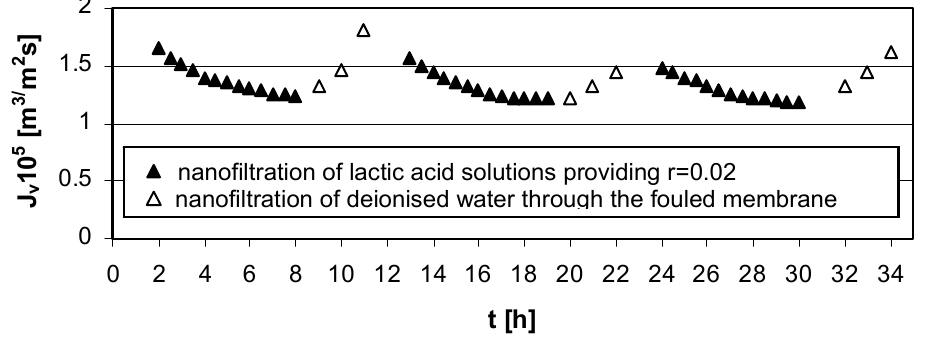
Figure 5. Permeate flux decline vs. time for operating parameters providing low lactic acid rejection, r = 0.02 (Table 1); series 1, 2, 3—nanofiltration of lactic acid solutions; series 1w, 2w, 3w—nanofiltration of deionized water; concentration of lactic acid c pH = 4.0, transmembrane pressure Δ p = 1.4 MPa, cross flow velocity u = 2.6 m/s.